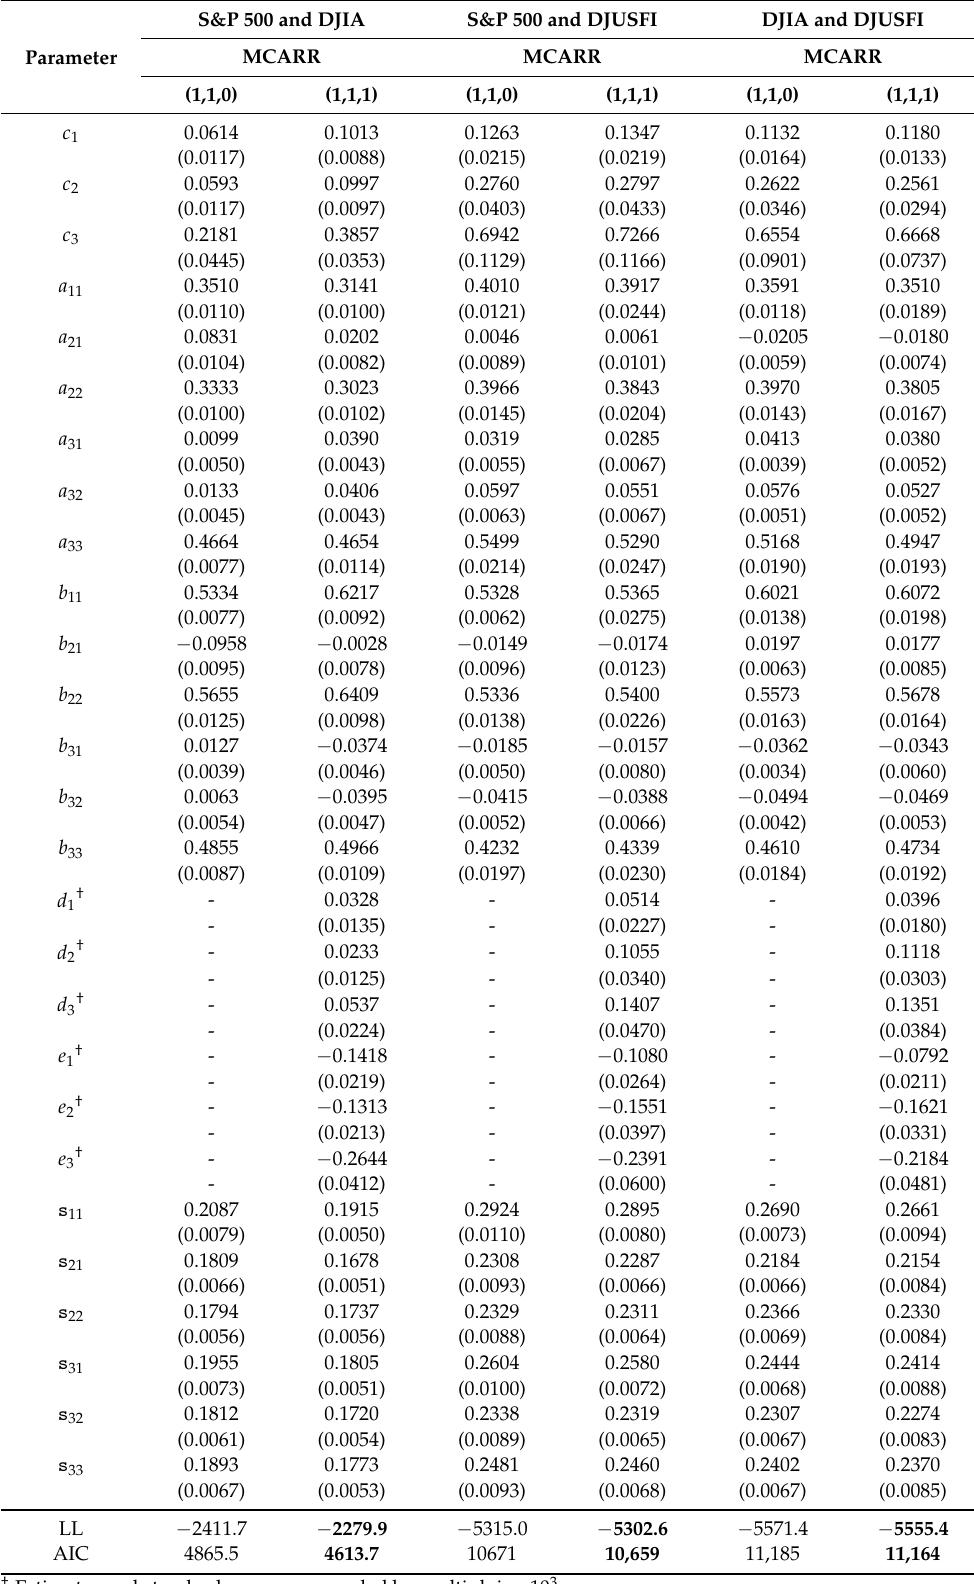
Table 2. Parameter estimates, standard errors (in parentheses), model performance measures LL and AIC for in-sample estimation of the MCARR(1,1,0) and MCARR(1,1,1) models with the pairwise combined indices. Models with boldface LL and AIC are the best